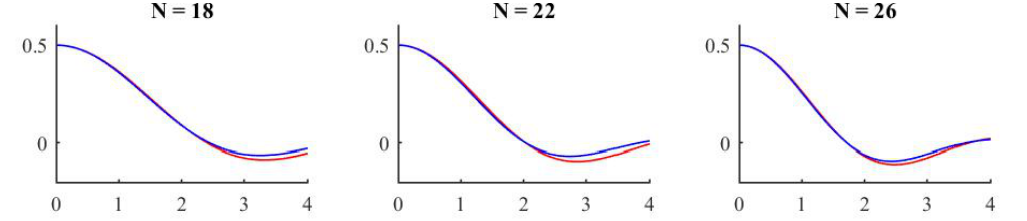
Figure 26 . We compare the expectation value of h 1 ( t ) 1 (0) i in the thermal state (blue) and pure state (red).